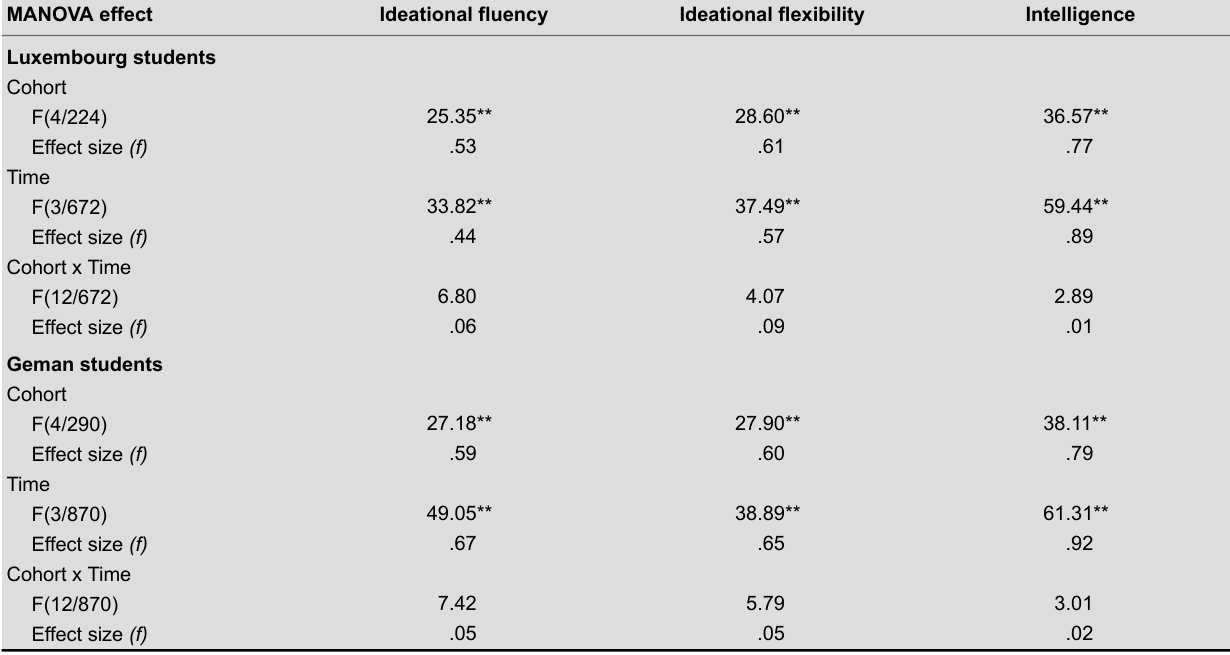
Results of Analyses of Variance for Ideational Fluency (FLU), Ideational Flexibility (FLE), and Intelligence (IN) With the Between Factor Educational Cohort (5) and the Repeated Measurement Factor Time of Measurement (4) in the Luxembourg Sample (N = 228) and the German Sample (N =